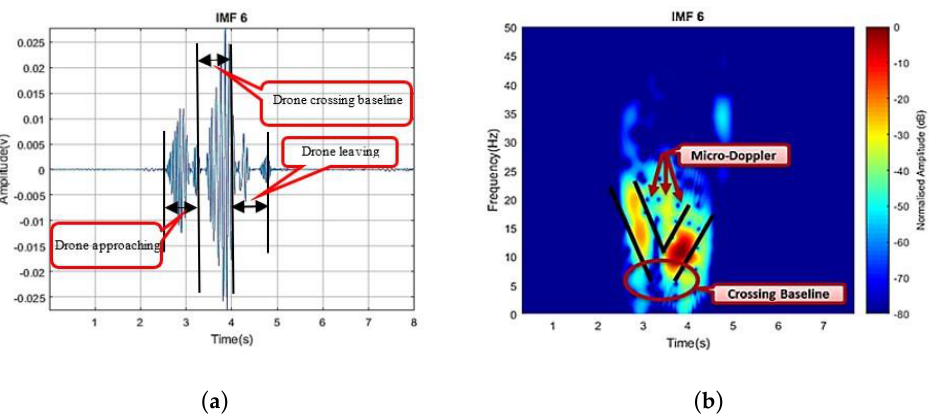
Figure 11. Extracted Doppler Component IMF6 ( a ) time domain and ( b ) its corresponding STFT plot. Signal 2 (Test 2)